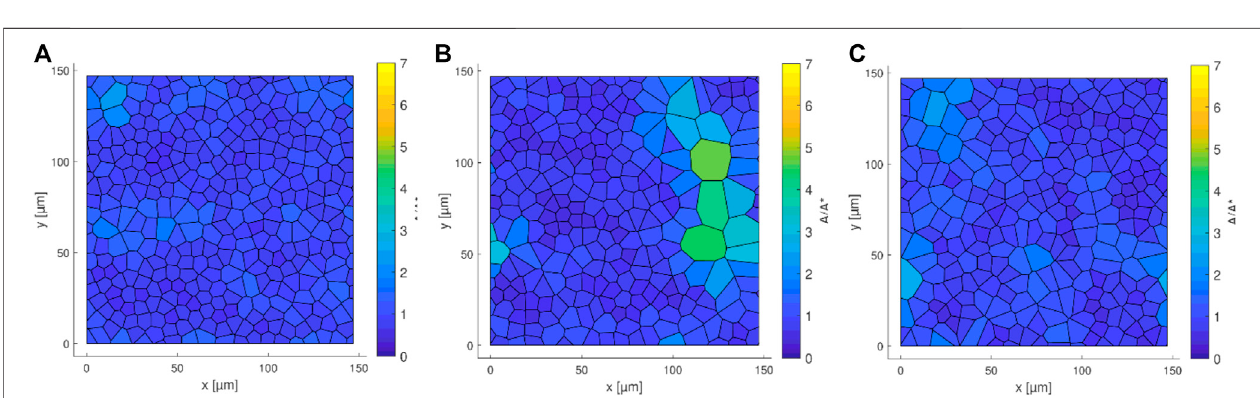
FIGURE 5 | Voronoi polygon areas of three MVEs of Figure 1 ; Larger inter- fi ber gaps lead to larger Voronoi-polygon areas; (A) detail 1; (B) detail 2; (C) detail 3.